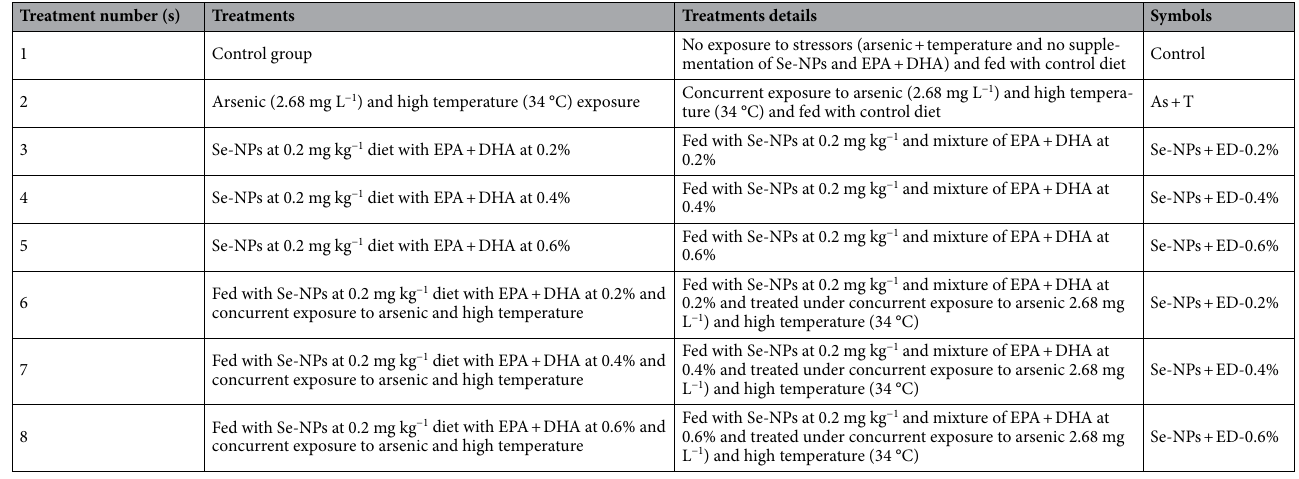
Table 2. Details of the experimental design.